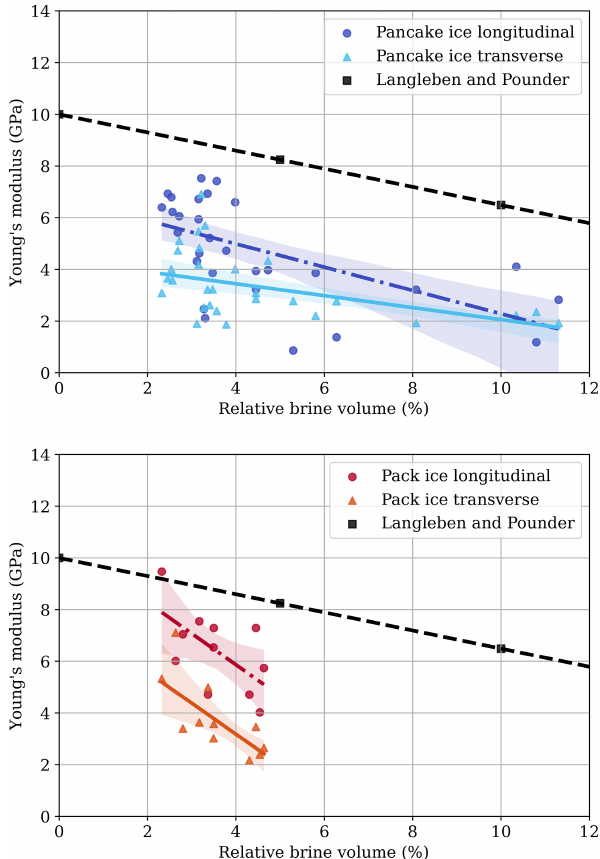
Figure 13. Longitudinal and transverse shear modulus for pancake ice cores M01-US-01-A, M01-US-01-B, M01-US-01-C, M01-US- 01-D, M01-US-02-A, M01-US-02-B, M01-US-02-C and M01-US- 02-D as well as consolidated pack ice cores M03-US-01-A and M03-US-02-A as a function of depth from the top of the ice. The shading indicates the 90th-percentile confidence intervals.